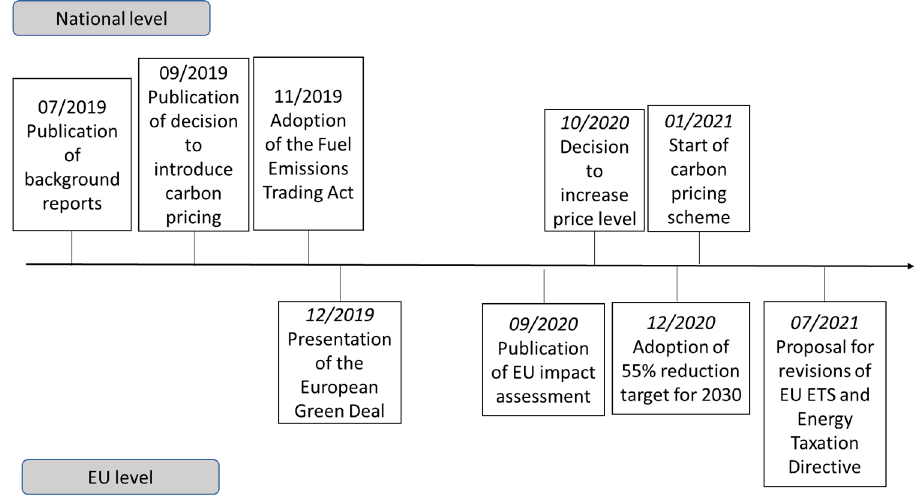
Figure 2. Overview of timeline of policy processes in the context of the introduction of carbon pricing in Germany.d